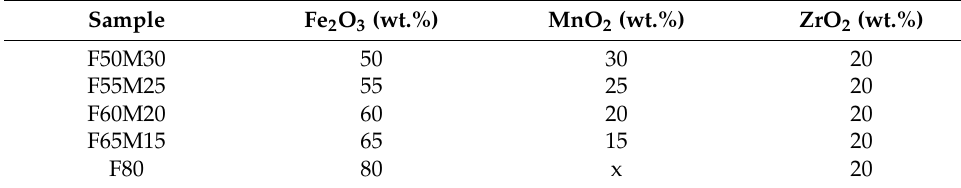
Table 4. The obtained OC